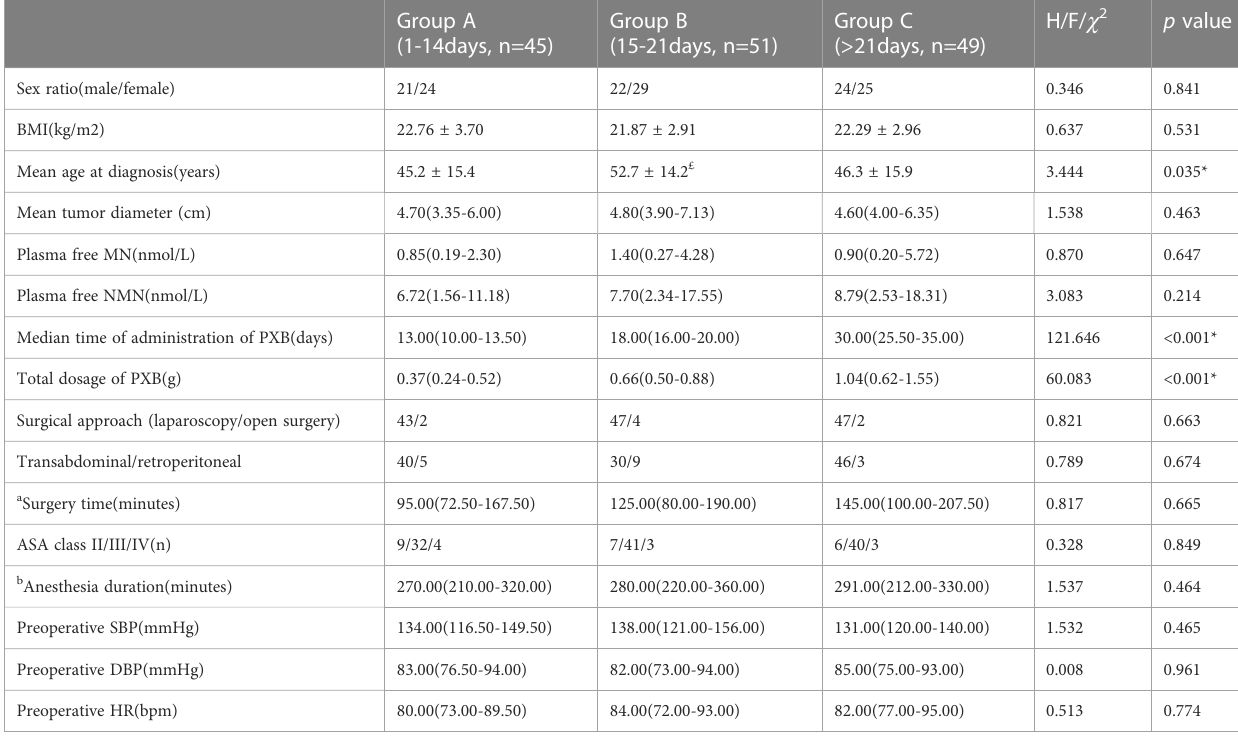
TABLE 2 Characteristics of three groups with PPGL according to the duration of administration of